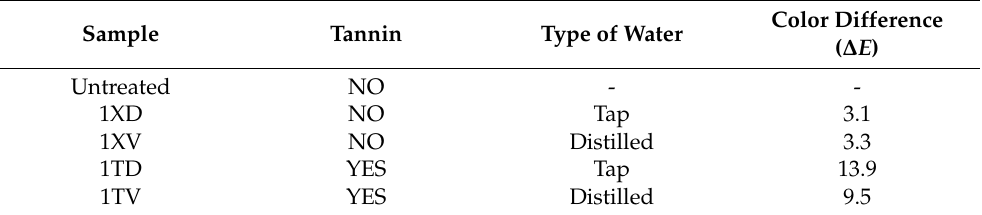
Figure 4. ( a ) Pre-mordanted samples and ( b ) the K/S values of the untreated and pre-mordanted samples. Table 4. Colorimetric values obtained from the study of mordanting variables considering the untreated sample as a reference.